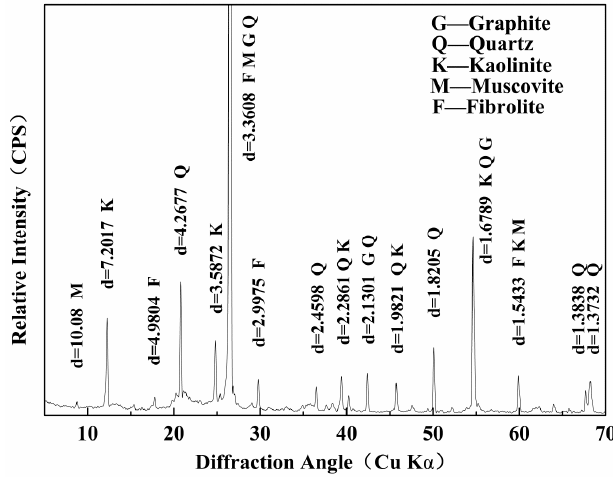
Figure 1. XRD pattern of the raw ore. Table 2. Mineral compositions of the raw ore (wt %).